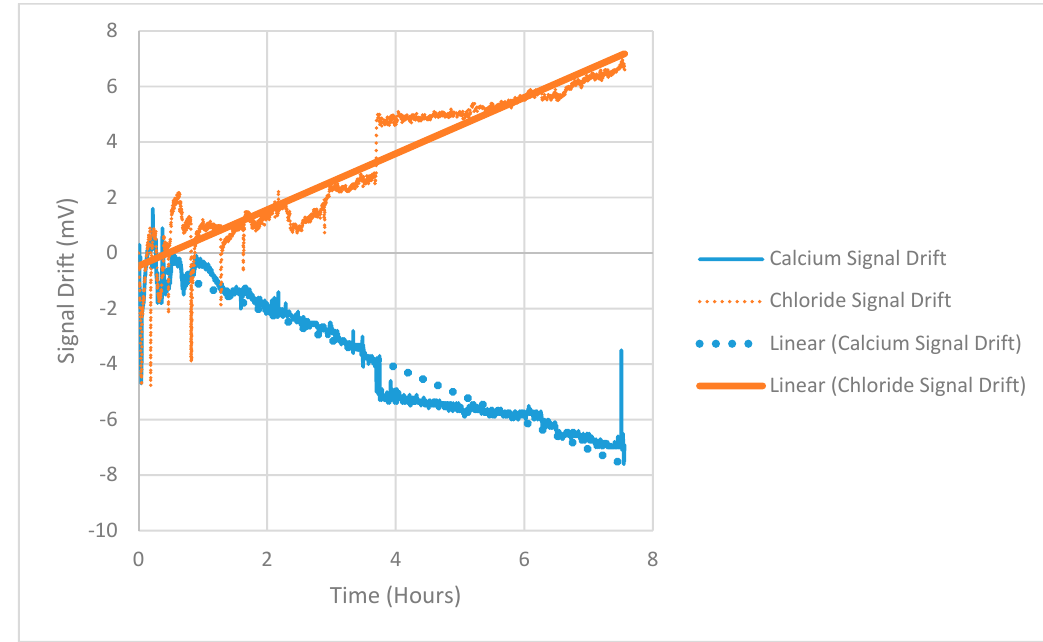
Figure 3. Unfiltered Readings of Calcium and Chloride ion selective electrodes (ISE’s) for Drift Quantification; showing generally linear drift over an 8 h period.